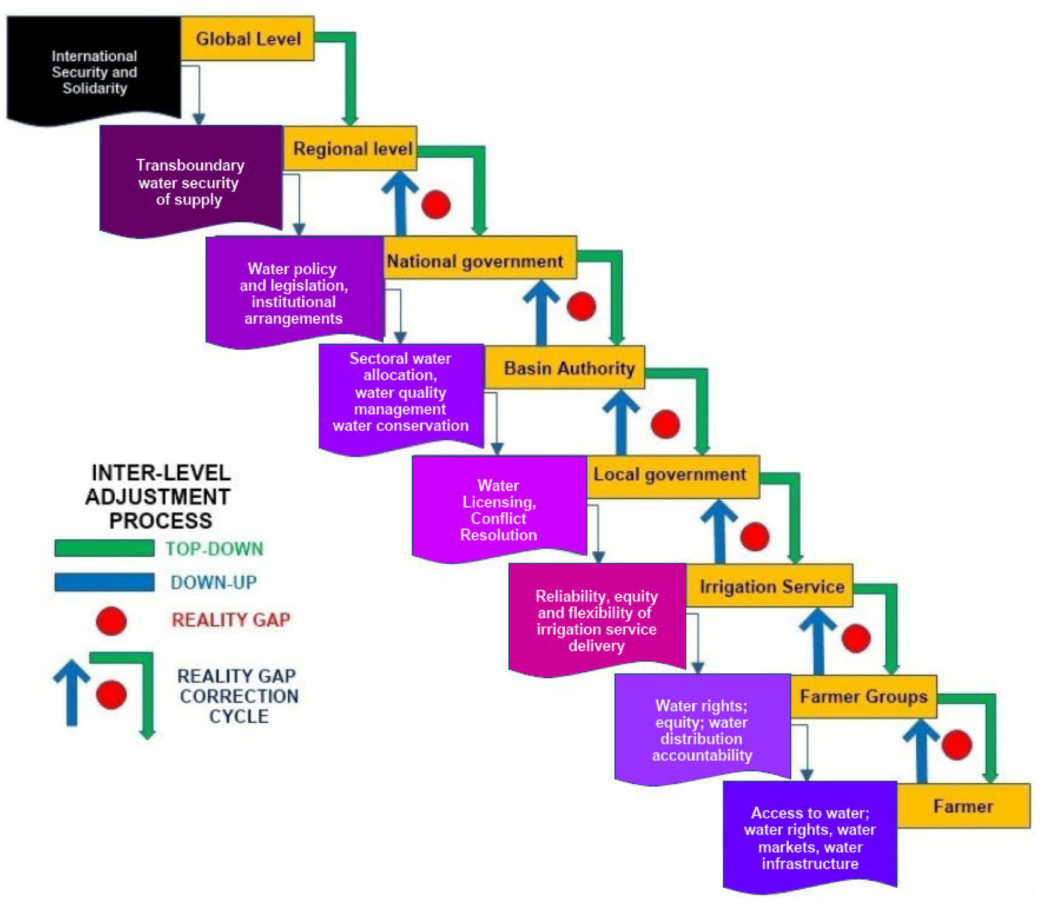
Figure 7. Reality Gap